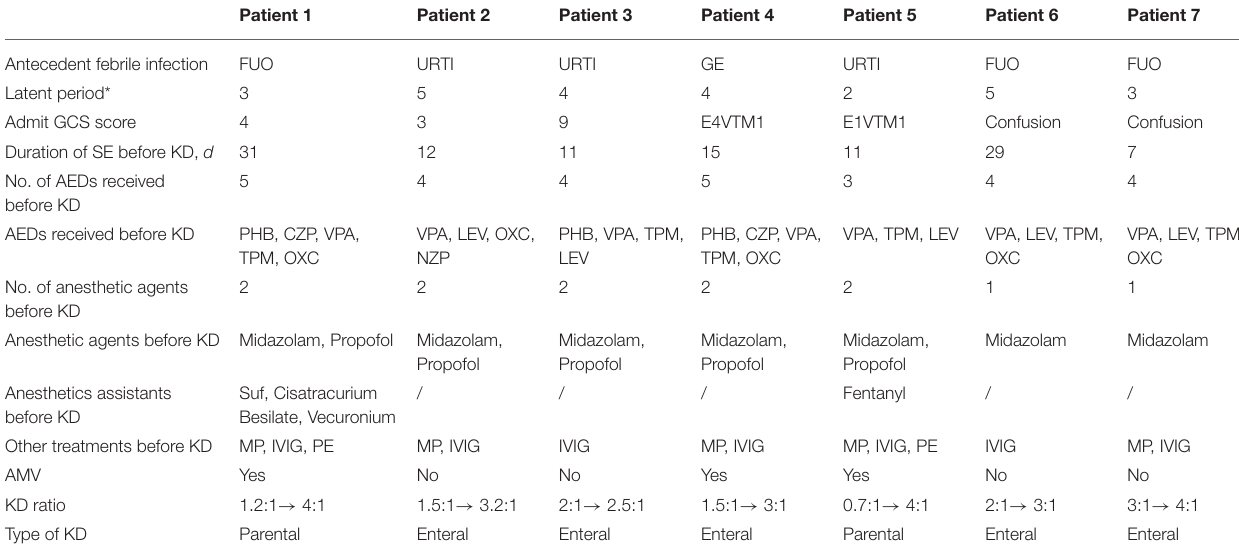
TABLE 1 | Patient characteristics and